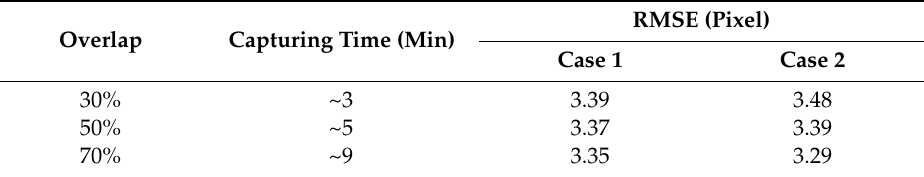
Table 4. Statistics of Figure 13 for comparing di ff erent overlap ratios and root mean square errors